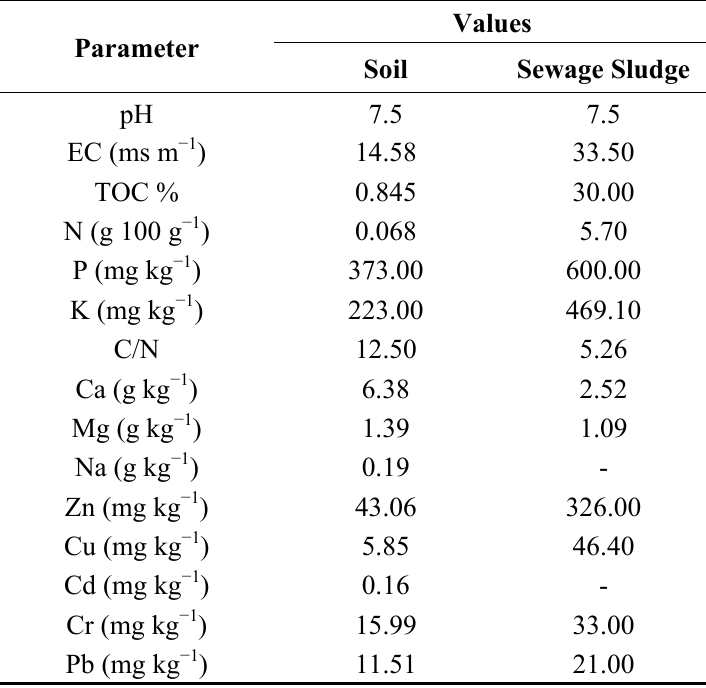
Table 1. Soil and sludge